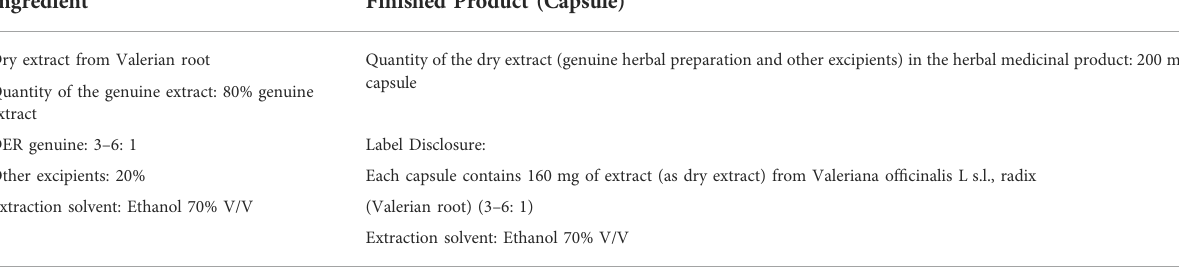
TABLE 2 Labeling of a fi nished product (capsule) containing Valerian Dry Extract according to EMA (European Medicines Agency (EMA), 2010) Ingredient Finished Product (Capsule)